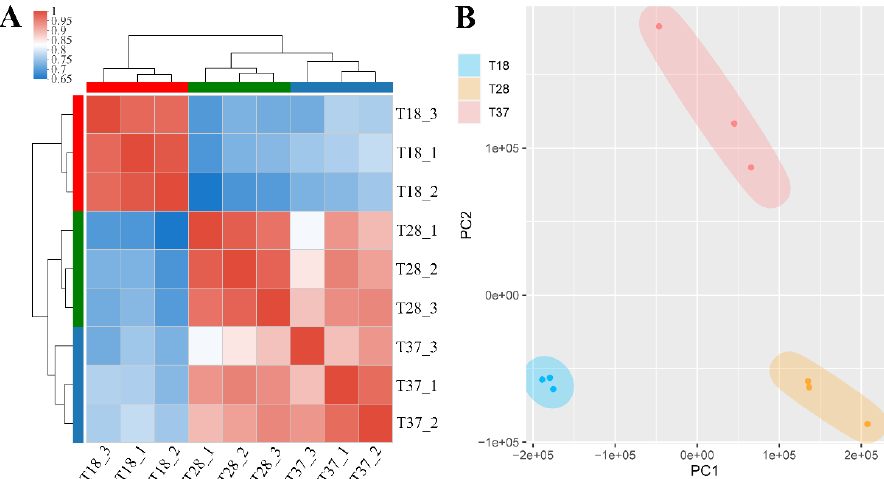
Figure 1. Evaluation of sample variance. ( A ) Heatmap showing the sample ‐ to ‐ sample distance (the squares with different colors represent the correlation between two samples.). ( B ) Principal component analysis of transcripts from A . salmonicida inoculated at 18 °C (blue), 28 °C (orange) and 37 °C (red).